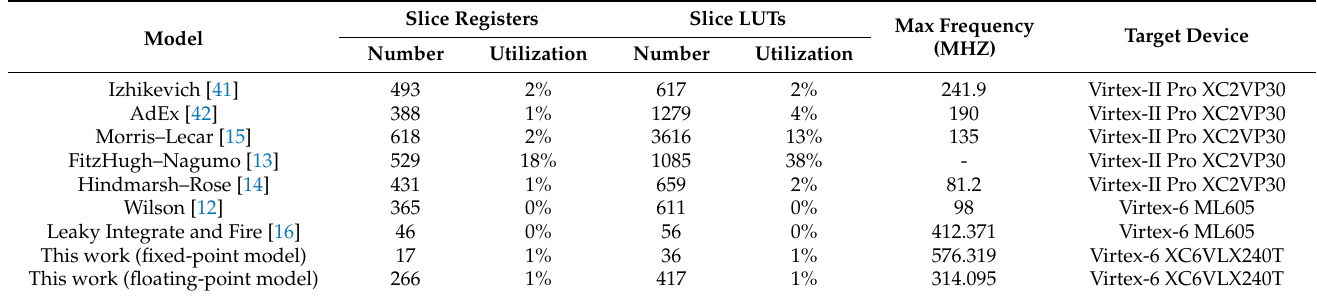
Table 1. Resource comparison of the simplified neuron with the related works.